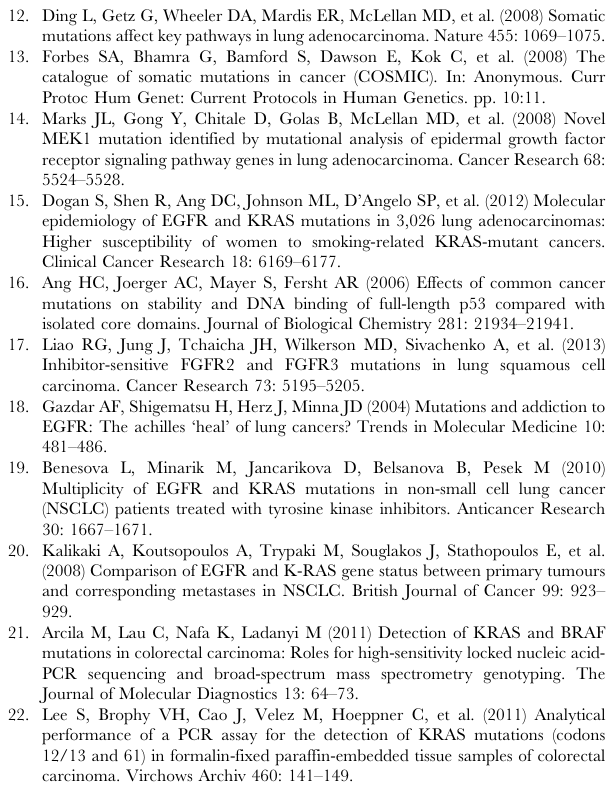
Table S1 All mutations detected by the customised MALDI- TOF panel, by sample.